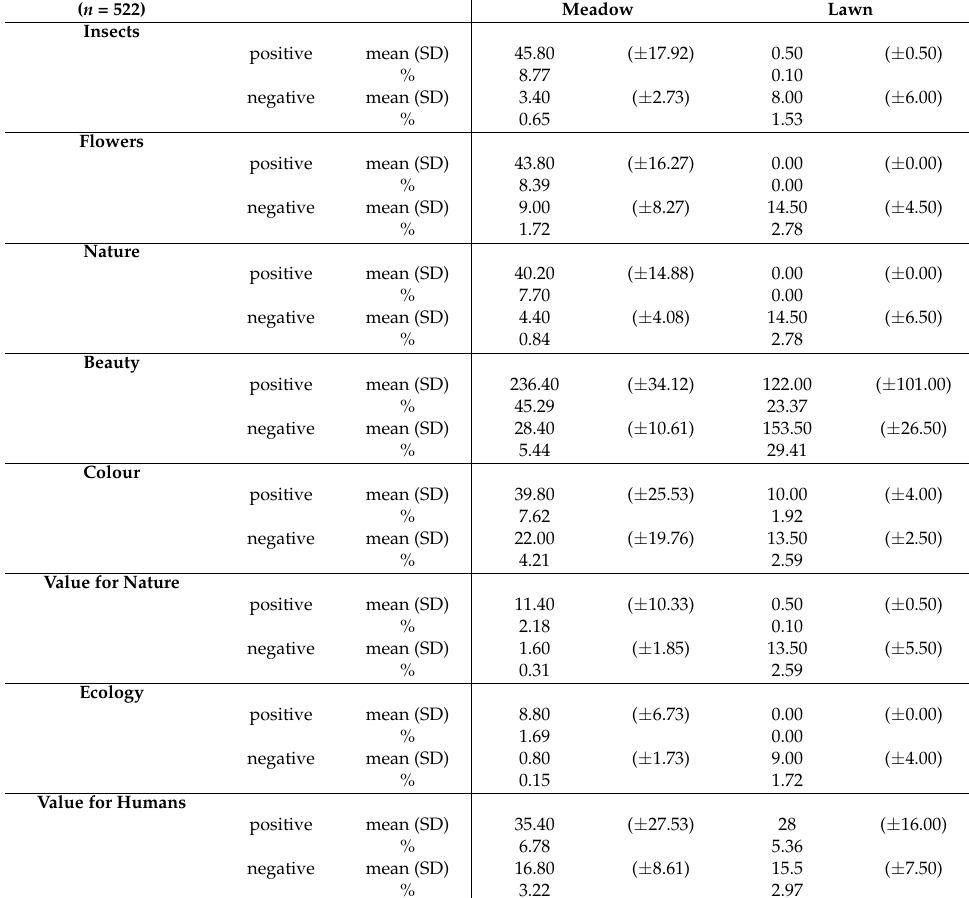
Table 2. Results of the first intuitive impressions when the participants were confronted with pictures of natural meadows. We rated positive and negative responses for each topic that we found (using grounded theory methodology (GTM)). The value represents the mean numbers of mentions per topic and percentage (for further explanation see text) of the five shown meadows and the two lawns. Multiple answers were allowed. SD = Standard deviation. n = 522. ( n = 522) Meadow Lawn